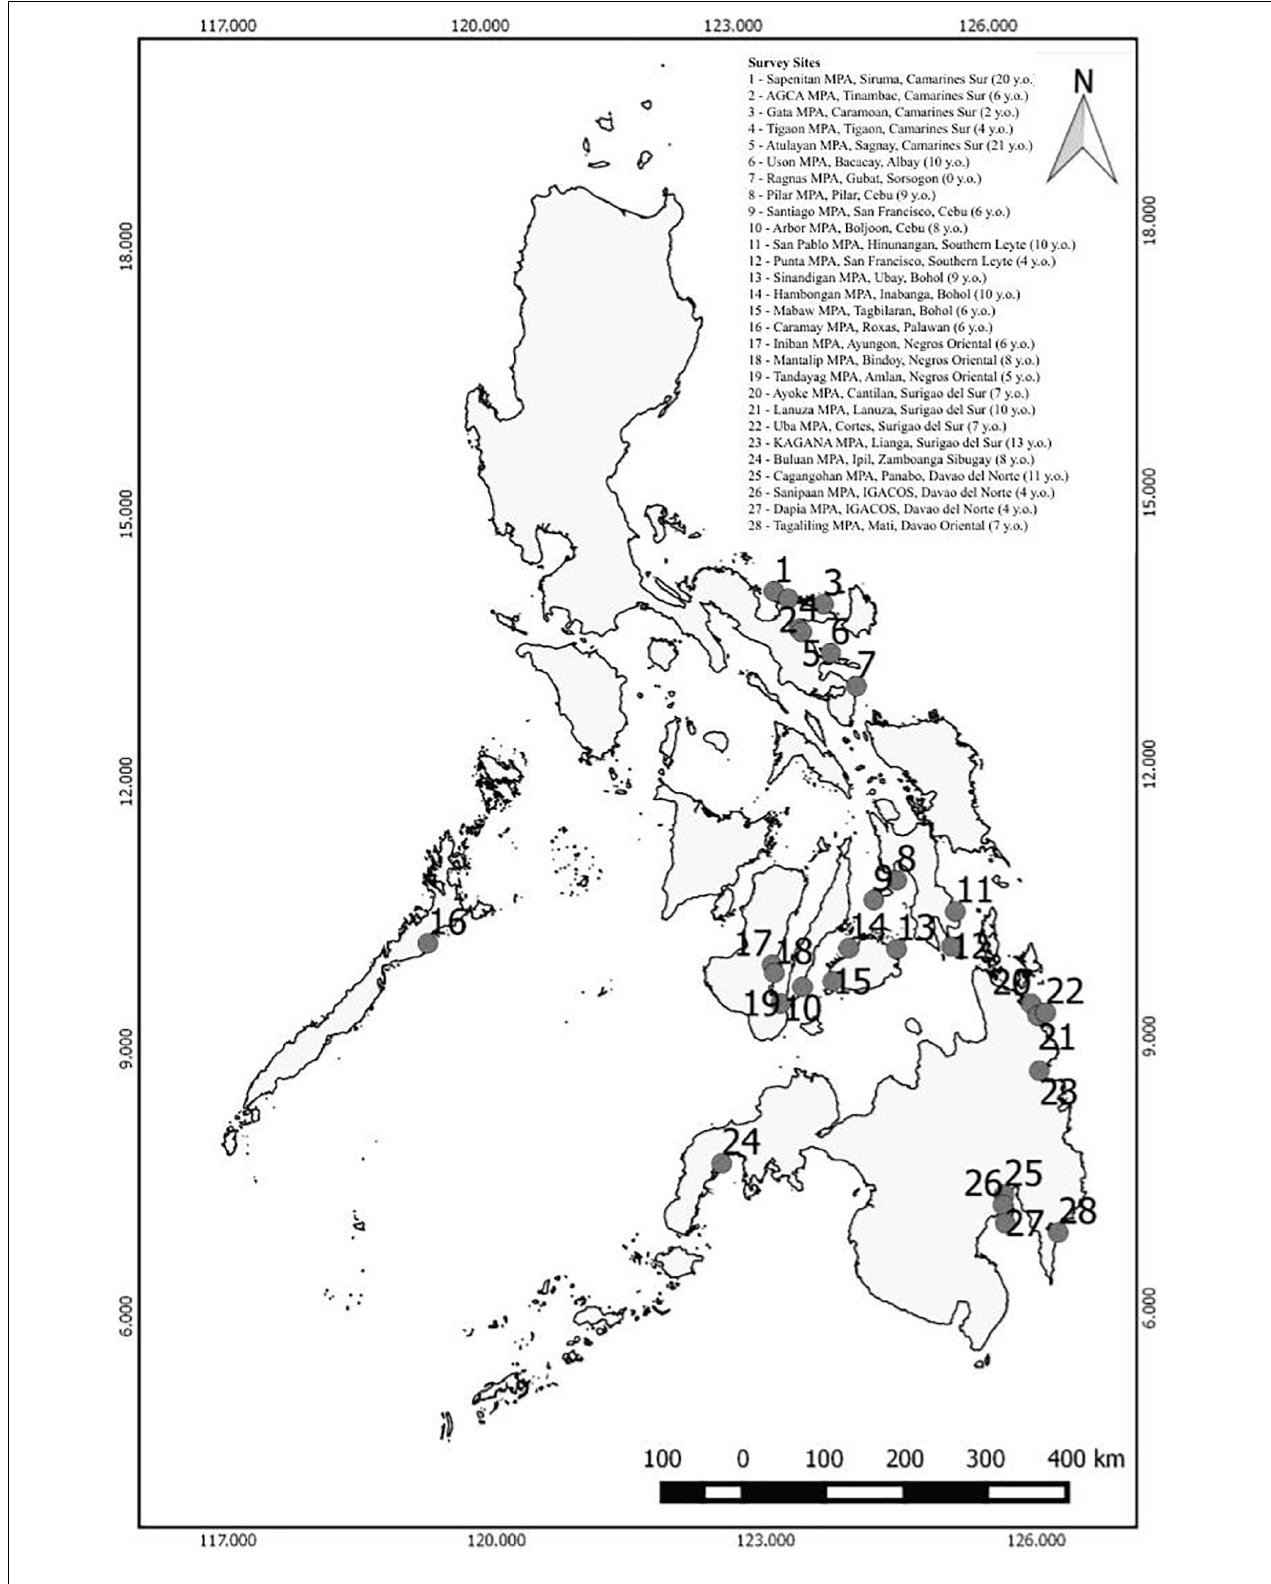
FIGURE 1 | Survey sites with MPA age at time of